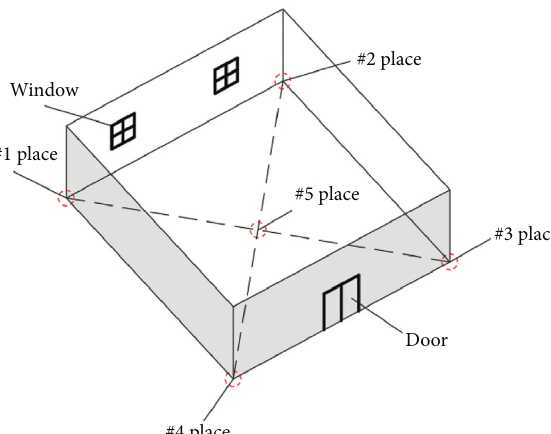
Figure 6: Schematic of five places in the experimental hall.